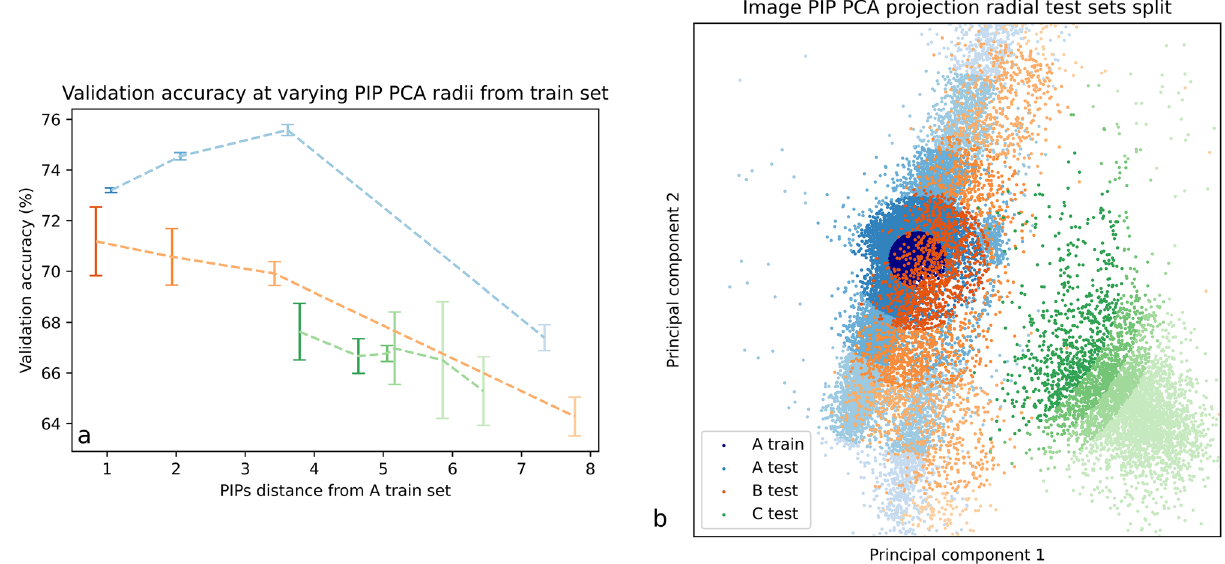
Figure 6. ( a ) Radial experiments in PIP space. Taking images exclusively from the center of the distribution of A for a training set and testing on test sets at different radii allows for the study of domain shift as a function of image distance from the training cluster PIP space. ( b ) “X-ray PIP-space” : PCA space for two principal components of 31,090 images PIPs for A, B and C